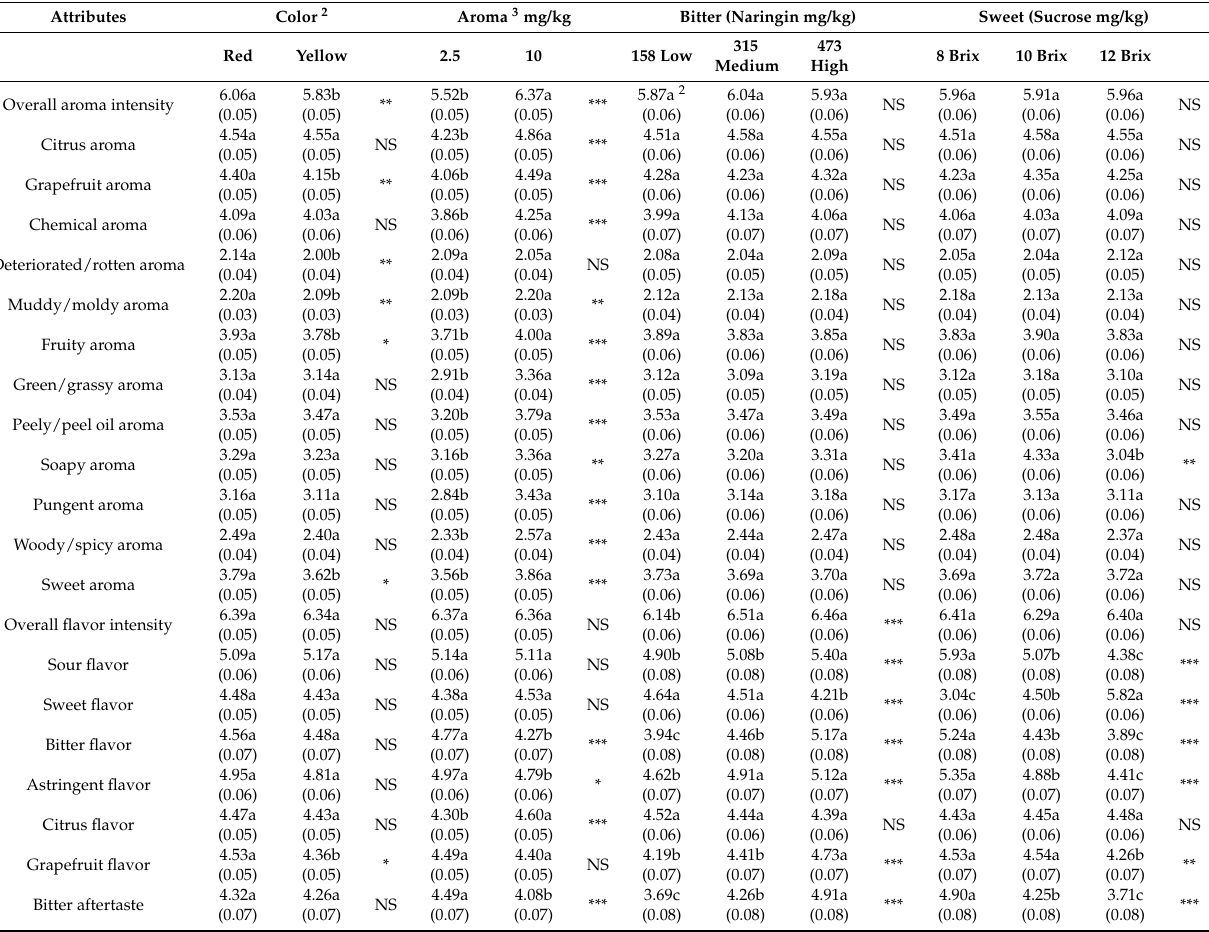
Table 3. Summary of the significance of varying the main effects of color hue, aroma, bitter, and sweet levels of a model grapefruit-like beverage, on the mean values 1 ( ± SEM) for sensory attributes as evaluated by a trained sensory panel ( n =